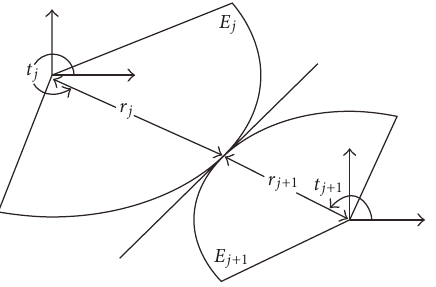
Figure 5: Definition of the search domain parameters. The relative position of centre of the secondary ellipse is determined from the condition that the two tangents coincide.